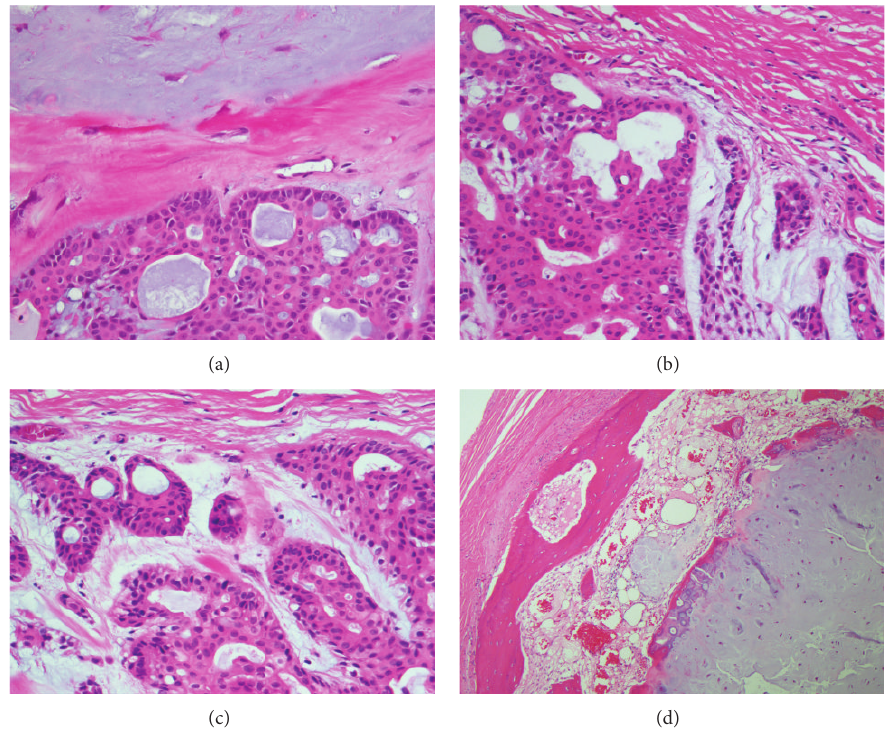
Figure 2: CXPA microscopic examination. (a) The benign myxoid component (top) is separated by a thick fibrous band from the malignant component (bottom). The neoplasm is composed of large cells with eosinophilic cytoplasm in a glandular pattern, H&E, 400x. (b) The well- circumscribed and encapsulated tumor shows areas of residual pleomorphic adenoma (lower right). A more cellular area (left) with irregular glandular architecture and composed of large cells with eosinophilic cytoplasm and pleomorphic nuclei is confined within the capsule, H&E, 400x. (c) The neoplasm is surrounded by a thin capsule (top) and cells show remarkable degree of cytological pleomorphism with hyperchromatic nuclei and prominent nucleoli, H&E, 400x. (d) The ossification comes from the periphery of the tumor within the capsule (left) and is present at the periphery of the benign components of the tumor (right), H&E,